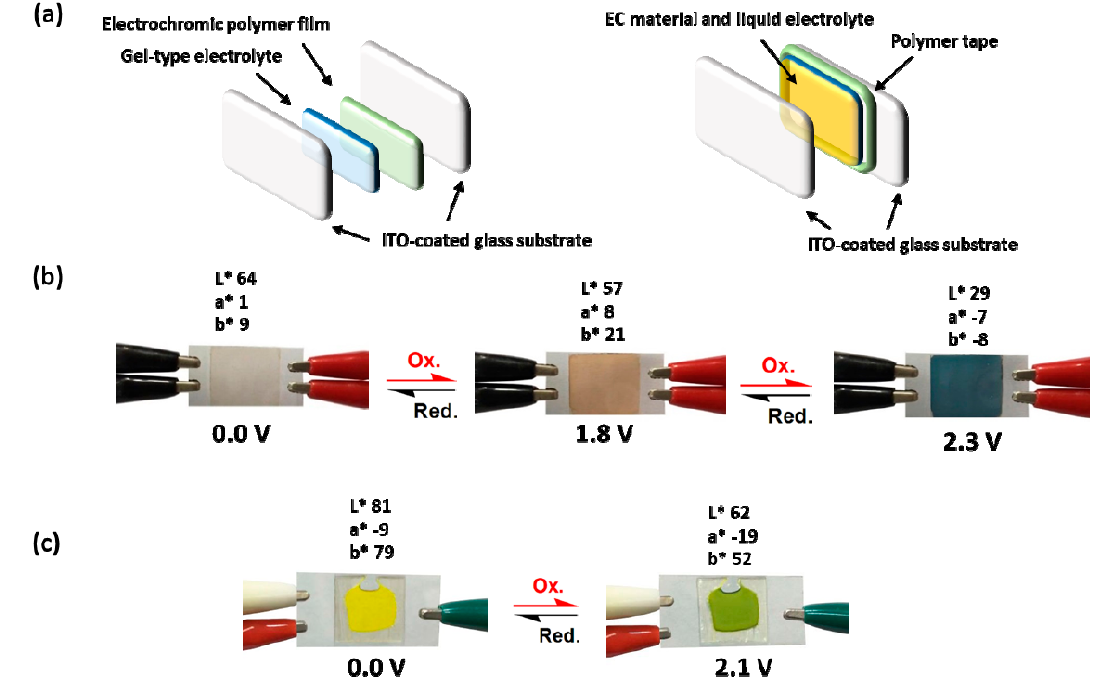
Figure 20. ( a ) Schematic illustration of the structure of the electrochromic device; ( b ) Image of the sandwich-type ITO-coated glass electrochromic cell, using TPA–TPPI as active layer; ( c ) Image of the liquid type ECD using the Bu 4 NClO 4 /propylene carbonate solution of M1 as the electrochromic